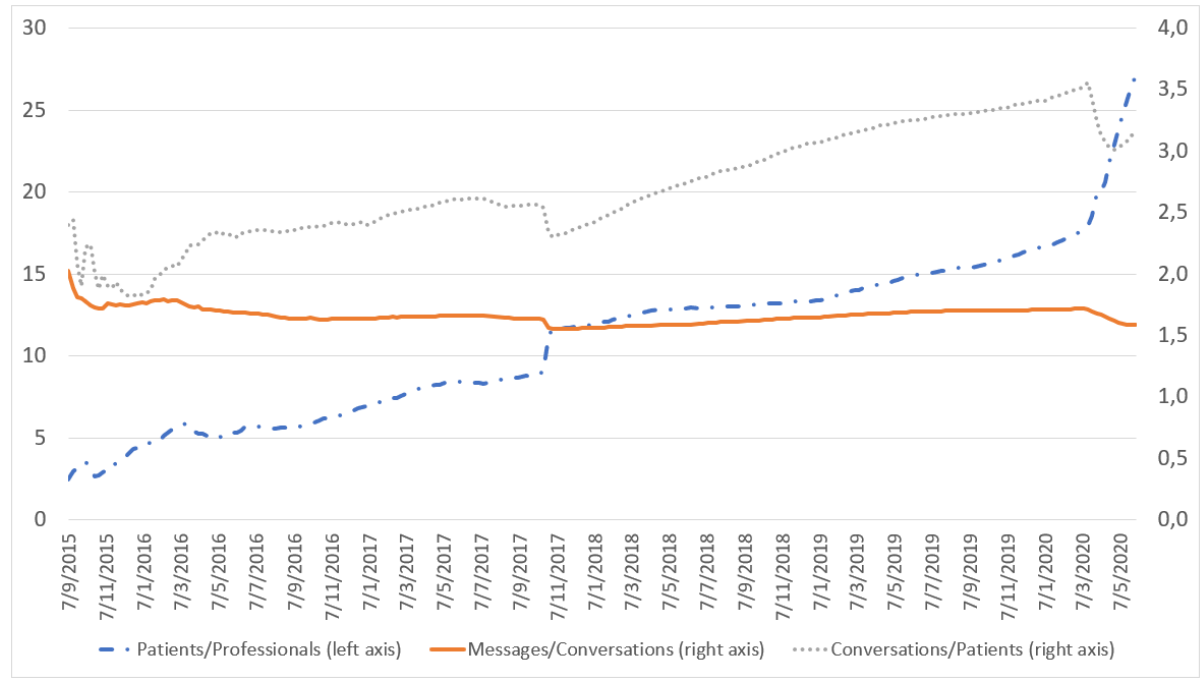
Figure 2. Patients per professional (left axis), messages per conversation and conversation per patient (right axis) in